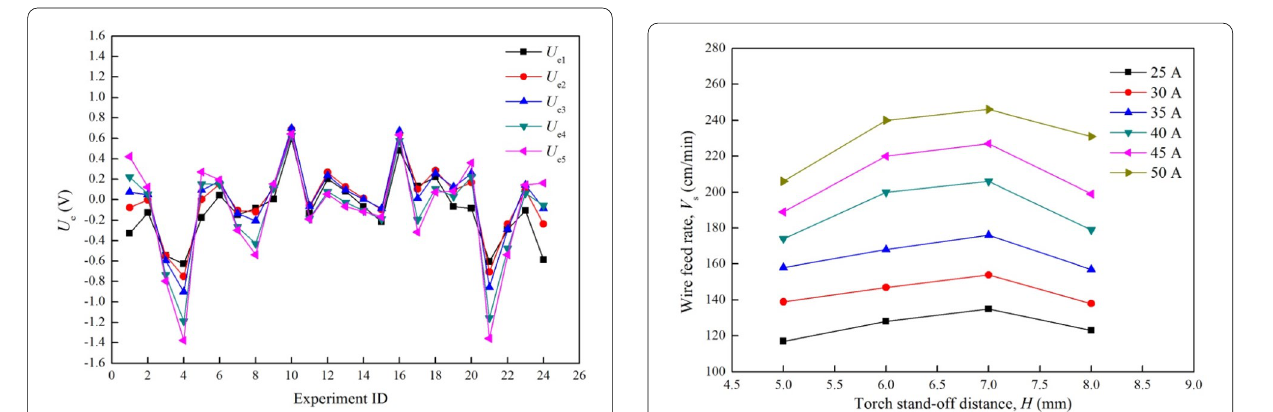
Figure 7 Relationships between wire feed rate and torch stand-off distance for different total